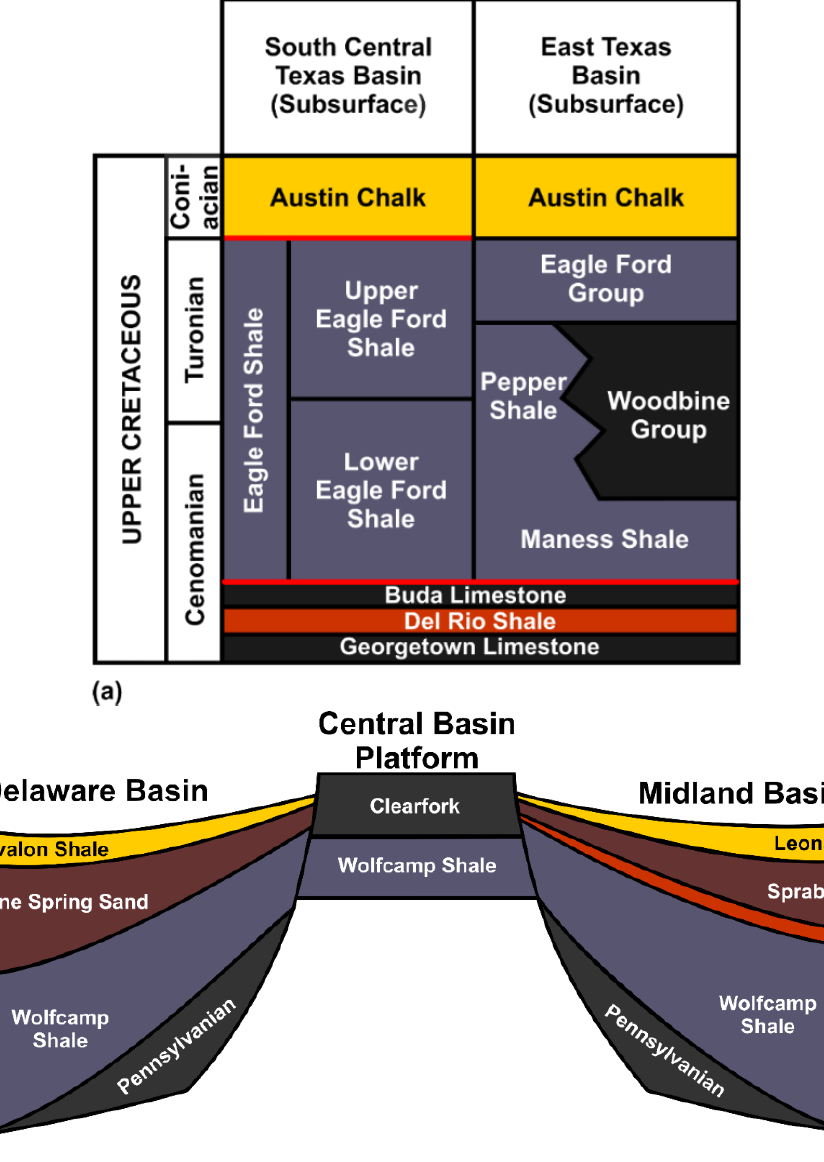
Figure 2. ( a ) Stratigraphy of the Eagle Ford Shale (Modified after: Workman [42]), and ( b ) Stratigraphy of the Wolfcamp shale from the Delaware Basin, extending through the Central Basin Platform to the Midland Basin (Modified after: Sutton [41]).